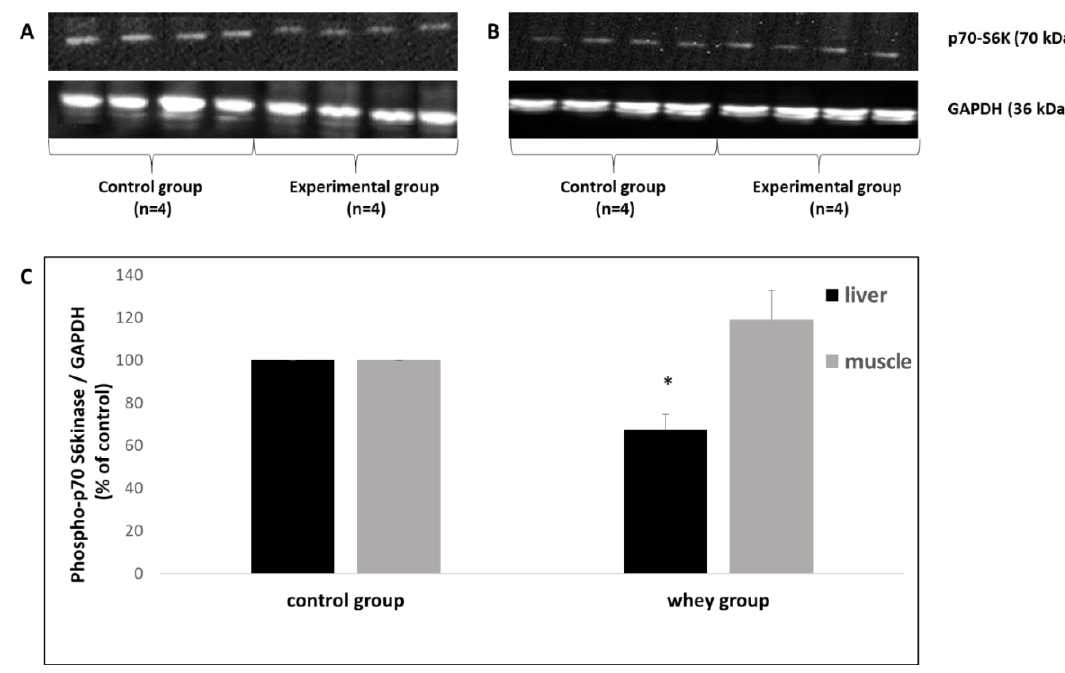
Figure 4. Representative western blots illustrating the effect of sheep/goat whey protein administration on the expression of p70-S6 Kinase (p70-S6K) in ( A ) liver and ( B ) quadriceps muscle of 4 rats. Glyceraldehyde 3-phosphate dehydrogenase (GAPDH) was used as the loading control for normalization. ( C ) The results are presented mathematically after the quantification through densitometry. *: Statistically significant compared to the control group ( p < 0.05).